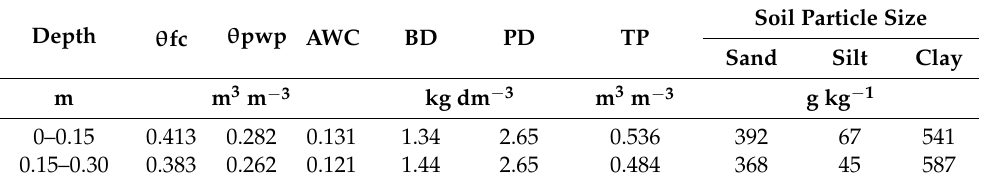
Table 1. Physical-hydric properties of the clayey Rhodic Hapludox in the center pivot agricultural area. Chapad ã o do Sul, MS, Brazil.